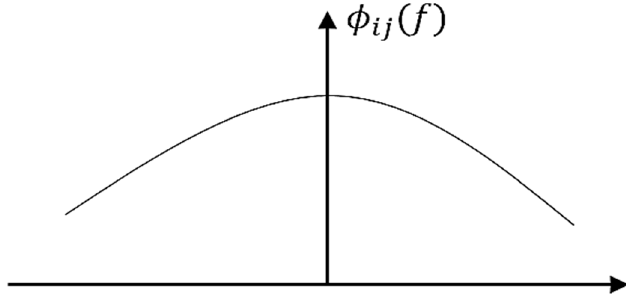
Figure 11. The power spectral density of the digital filter output 𝑥 (cid:4593) (𝑛) .